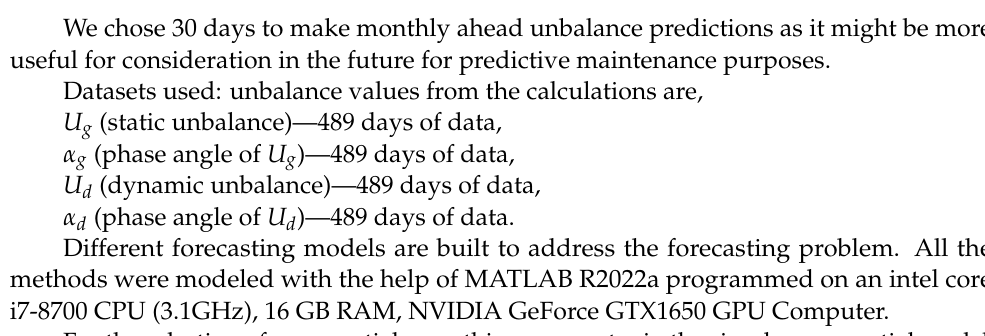
Figure 7. Expanding and sliding window methodologies for forecast.